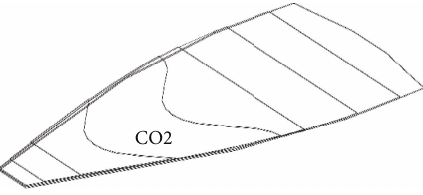
Figure 1: Geometry of 3D fin.